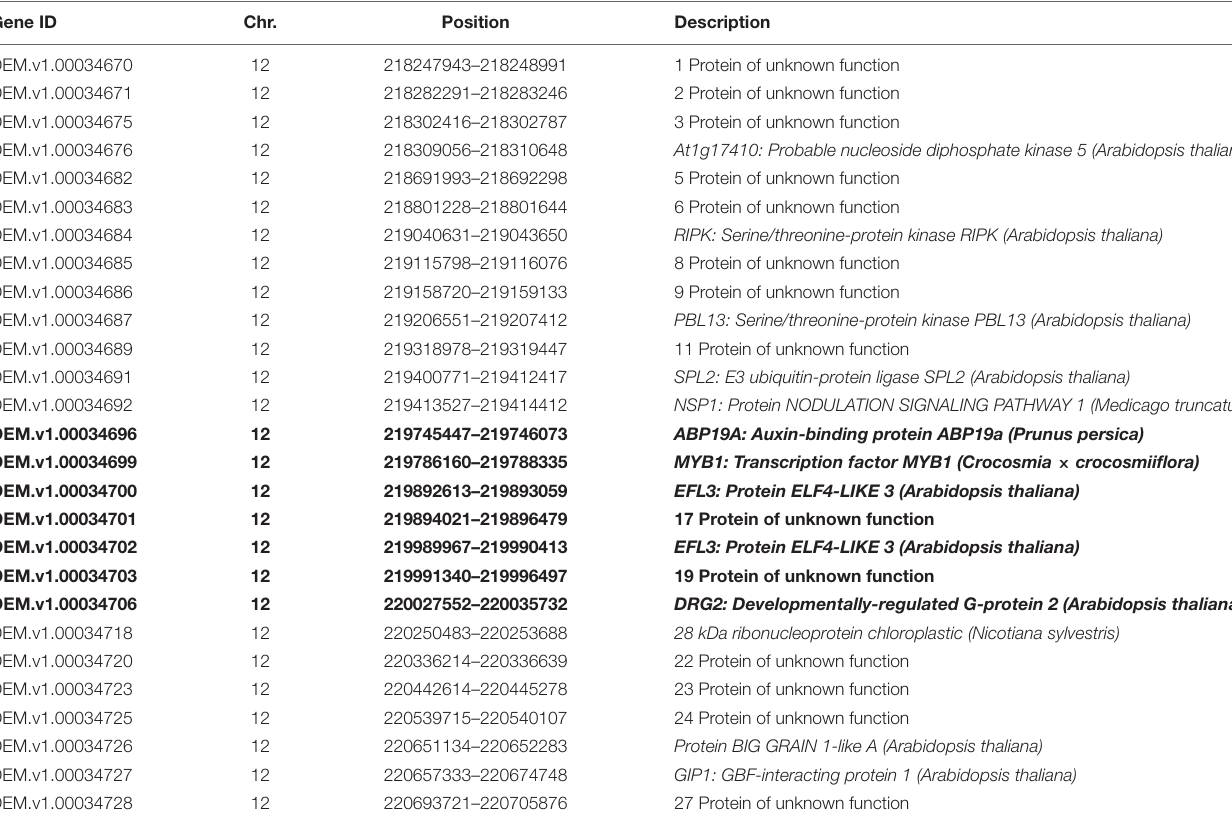
TABLE 4 | Candidate genes in the CapUp mapping region. Gene ID